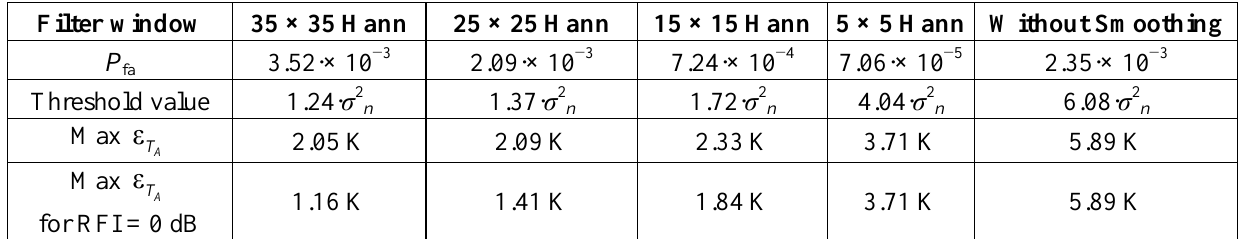
for four different cases of fa